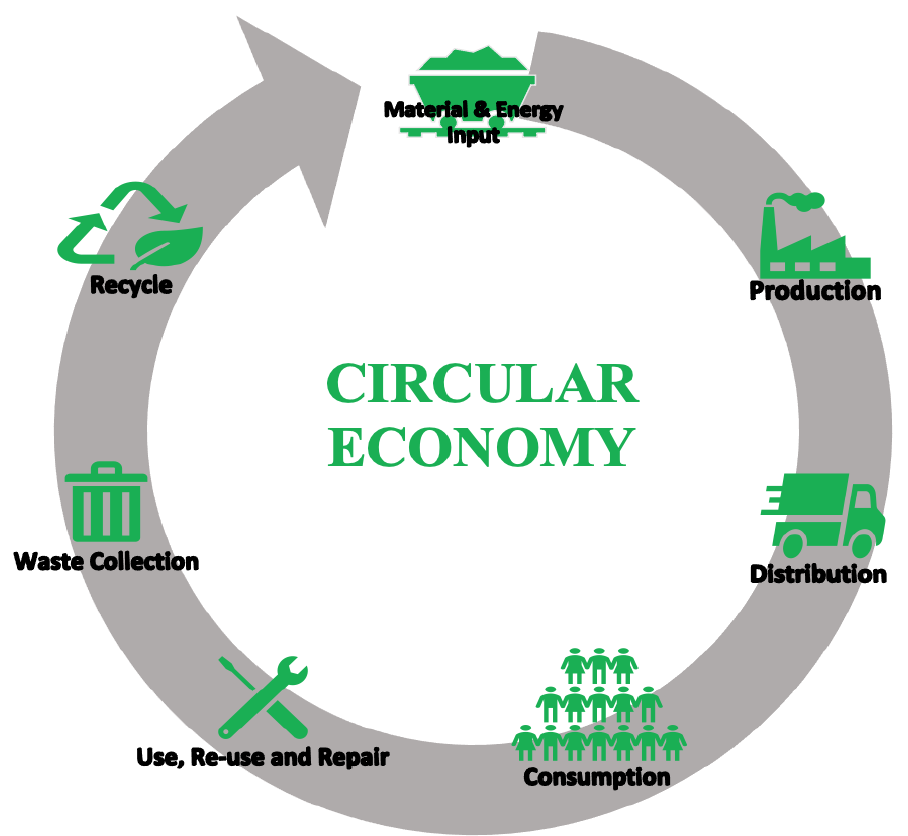
Figure 4. Circular economy process.